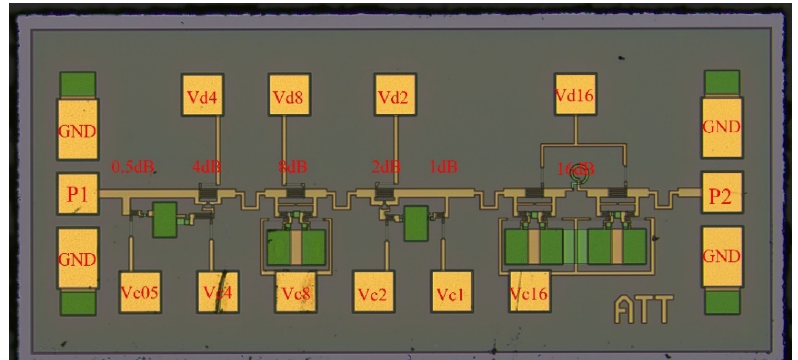
Figure 5. Photo of the proposed attenuator.